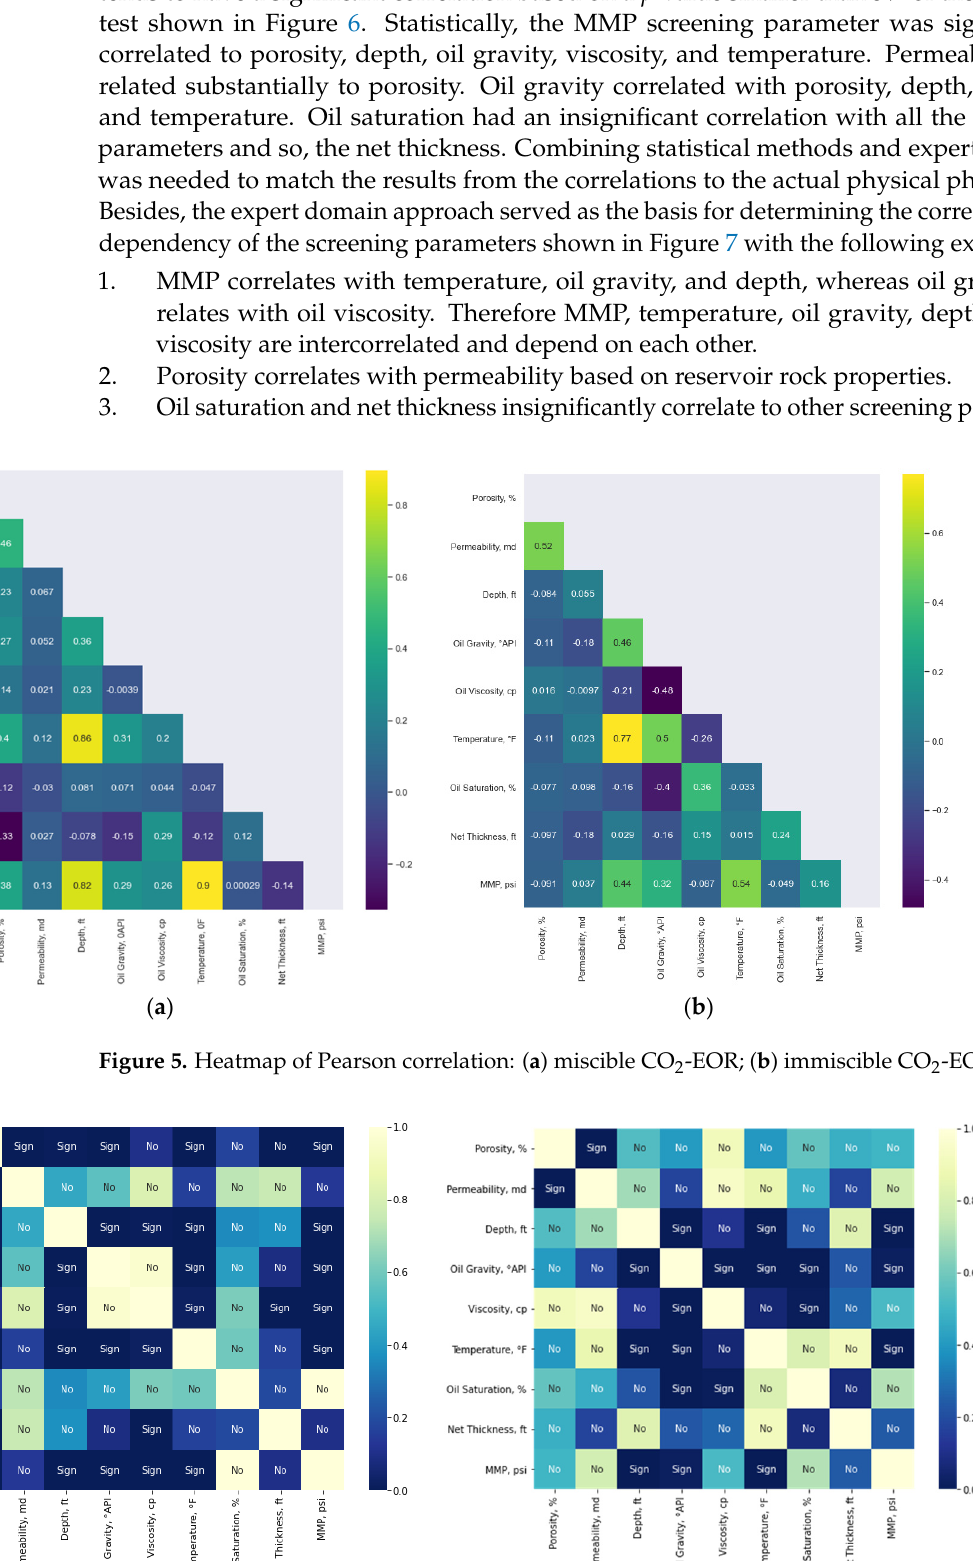
Figure 6. Heatmap of correlation significance test: ( a ) miscible CO 2 -EOR; ( b ) immiscible CO 2 -EOR.